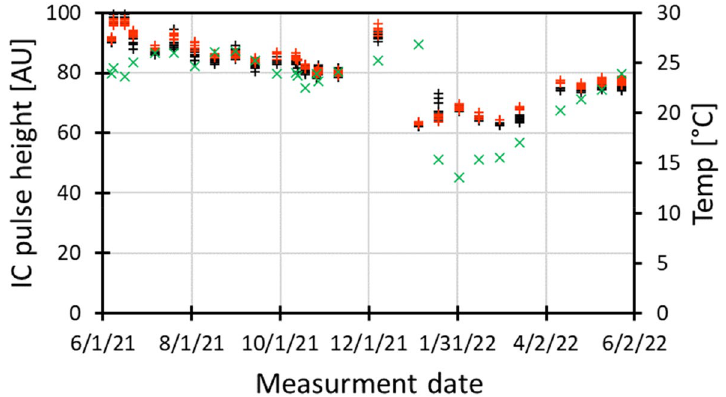
Figure 7. Average pulse height from the built in ion chamber for 2 pulse irradiations (red) and 3 pulse irradiations (black) in FLASH mode, over 12 months of experiments.The Xs denote the temperature in the room at the beginning of the